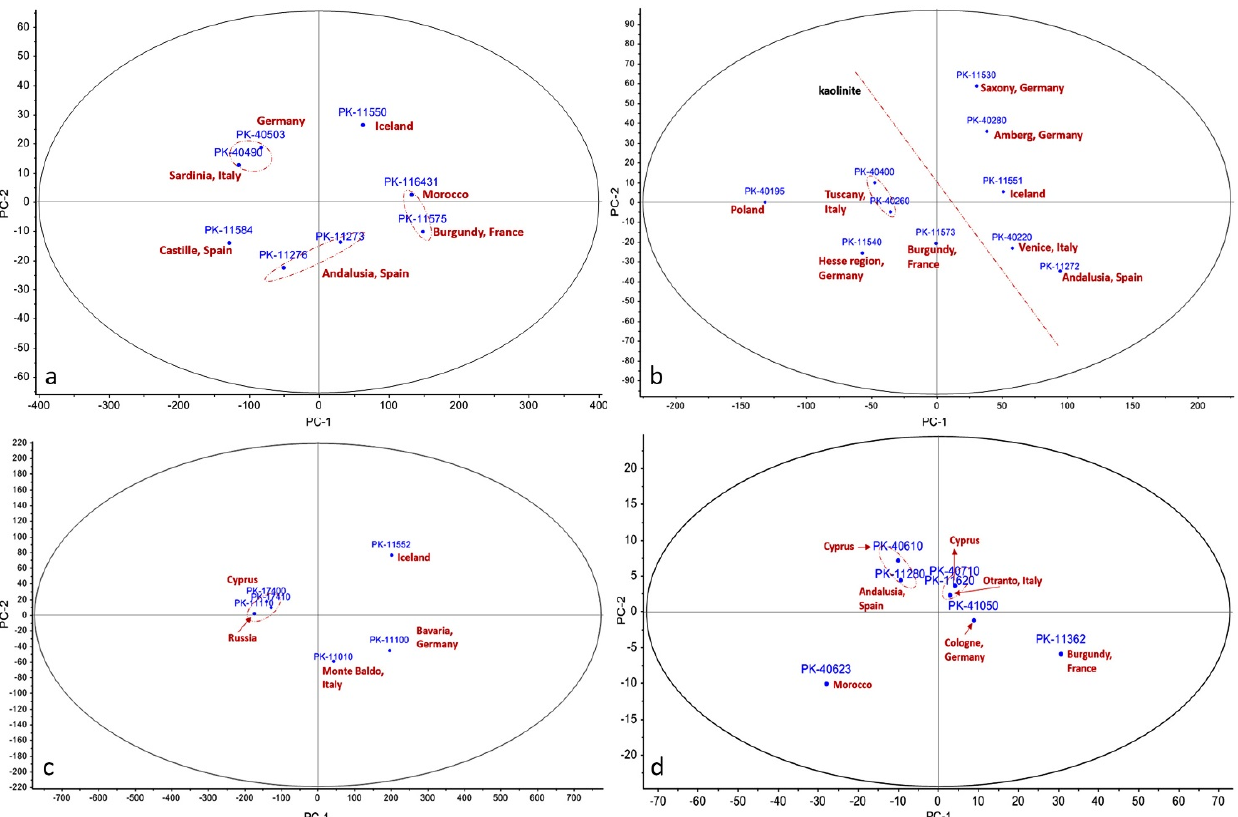
Figure 7. FTIR-PCA model of: ( a ) red ochers, ( b ) yellow ochers, ( c ) green earths, ( d ) brown and black earths.